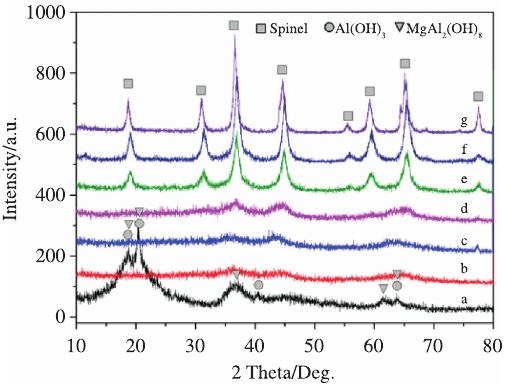
Figure 4. X-ray diffraction patterns of MgAl at 900 °C for 2h (a. SPAN-80 + Triton X-100, forward-titration; b. SPAN-80 + Triton X-100, reverse-titration; c. NP-40, forward-